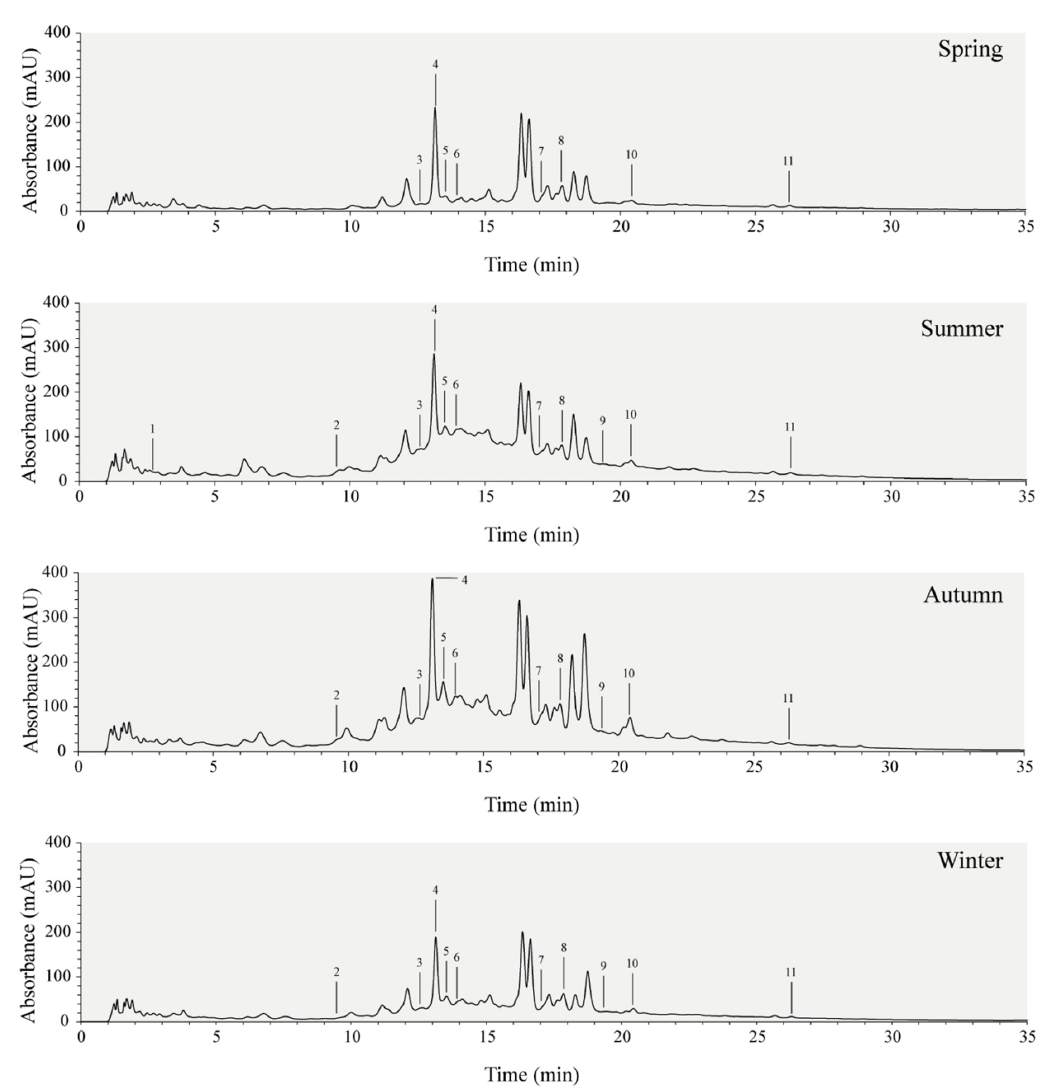
Figure 2. HPLC-DAD chromatograms of sawgrass ( C. mariscus ) acetone water extracts throughout the seasons.